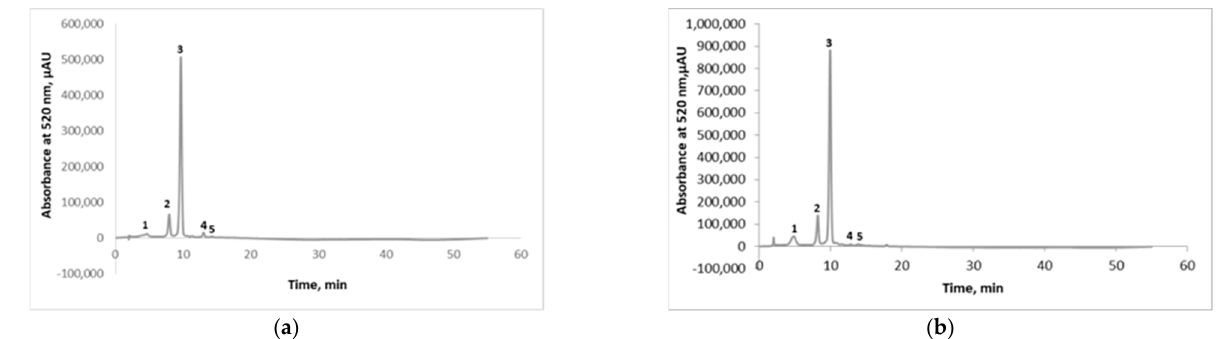
Figure 1. Chromatographic profile of eggplant peel extracts obtained by SLE with EtOH 96% for 30 min at 50 °C ( a ) and UAE with EtOH 96% for 30 min at 25 °C ( b ): Peak 1—delphinidin 3- O -rutinoside-5-glucoside; Peak 2—delphinidin 3- O -glucoside; Peak 3—delphinidin 3- O -rutinoside; Peak 4—cyanidin 3- O -rutinoside; Peak 5—petunidin 3- O -rutinoside.